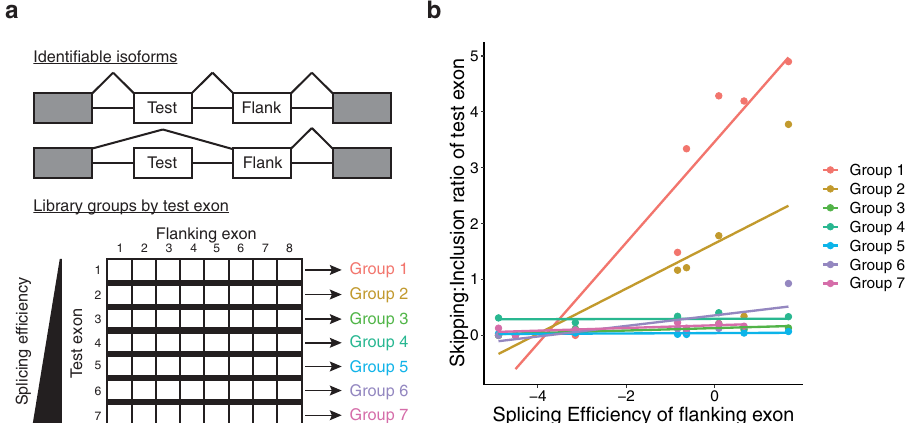
Fig. 6 Higher-order effects of fl anking exons on splicing. a Spliced isoforms that can be distinguished in RNA-seq. The minigene library was subdivided into seven groups, corresponding to the rows of the matrix. Each matrix element is a unique species, or pairing of test exons with fl anking exons. Thus, each library group represents the pairings of one test exon with all fl anking exons. The test exon used in Group 1 has the lowest splicing ef fi ciency of all of the test exons, while the one in Group 7 has the highest splicing ef fi ciency. b Skipping of the test exon is plotted as a function of the splicing ef fi ciency of the fl anking exon. Colors correspond to the library group of each species in panel ( a